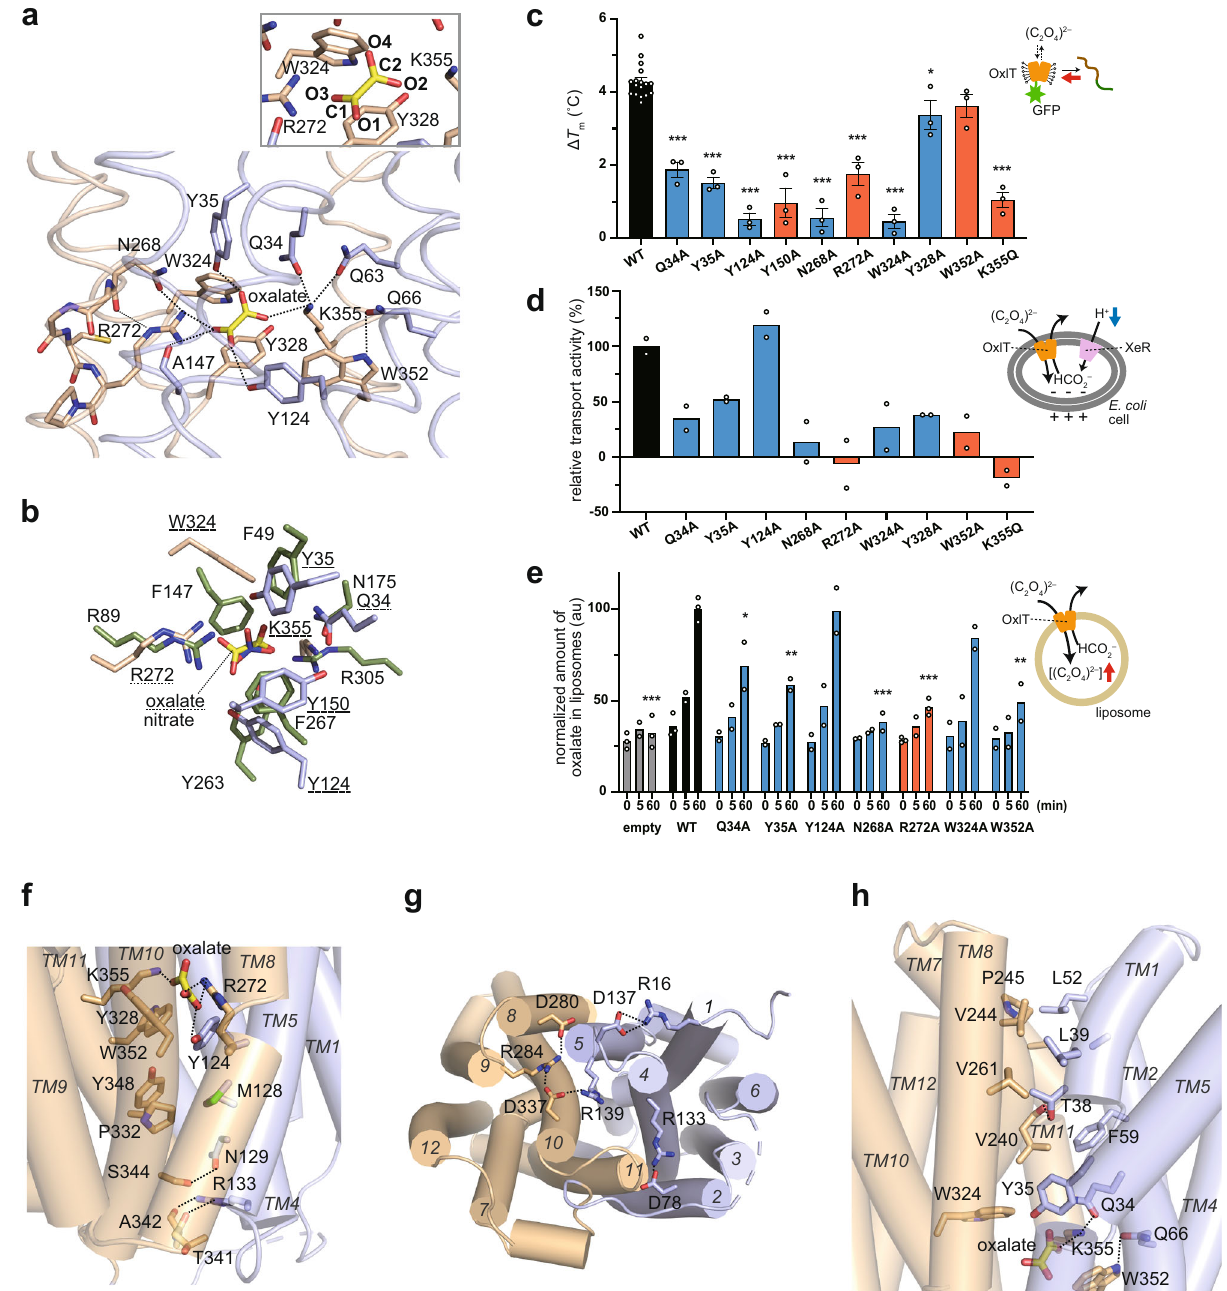
Fig. 2 | Oxalate-bound occludedOxlTstructure. a Close-up ofthebinding site in oxalate-bound OxlT (PDB ID: 8HPK). Dashed lines indicate potential hydrogen bondsandsaltbridges.Alsoshownamagni fi edviewoftheboundoxalatemolecule with atom labels. b Superposition of the substrate-binding site structures of OxlT (with the underlined labels) and NarK (green, with normal labels; PDB ID: 4U4W) based on the topological similarity of the amino acid residues interacting with the substrates. c Oxalate binding assay by GFP-TS. Data represent means±SEM of the increases in melting temperatures caused by the addition of 3mM potassium oxalate in three independent experiments. WT: wild-type. d Oxalate uptake assay using recombinant E. coli cells. The relative transport activities of the mutant OxlT tothatoftheWTOxlTmeasuredonthesamedaysetas100%,whilethatofthecells without expressing OxlT 36 was set as 0%, are displayed. The bars represent the means of the technically duplicated measurements from a single experiment for